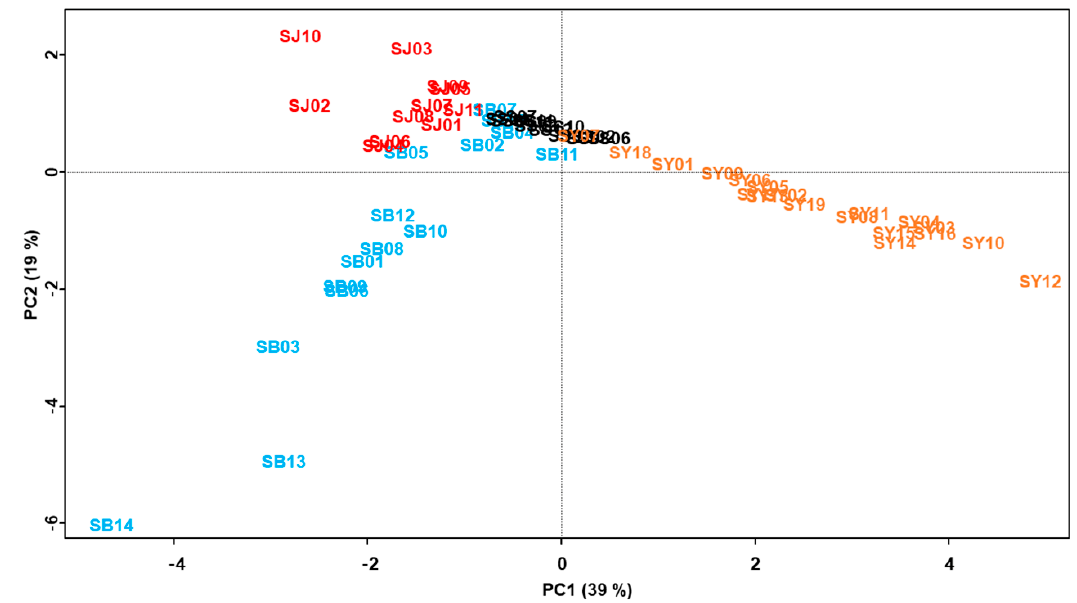
Figure 4. The principal component score plot (PC1 vs. PC2) from the 12 marker compound contents of the Morus samples. PC1 and PC2 contributed to 39% and 19% of the total variance, respectively. SB, root barks; SJ, twigs; SS, fruits; SY, leaves.